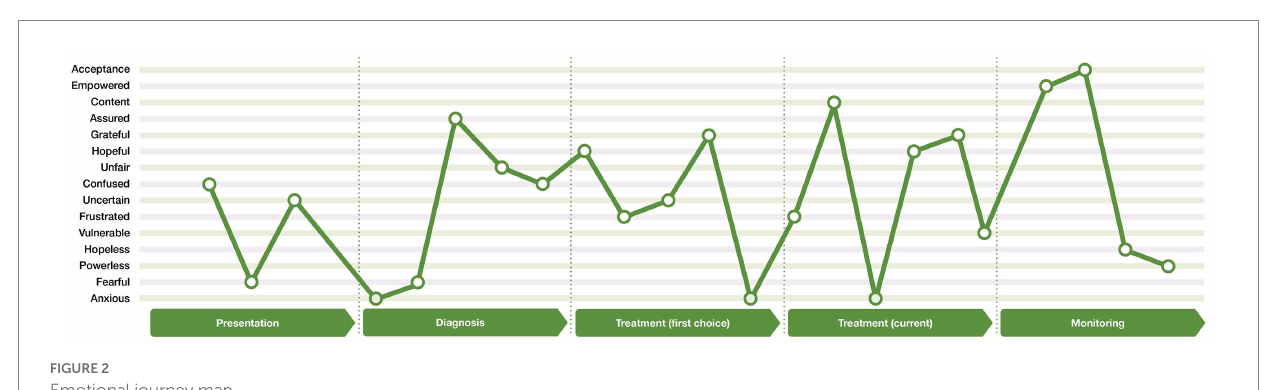
FIGURE 2 Emotional journey map.